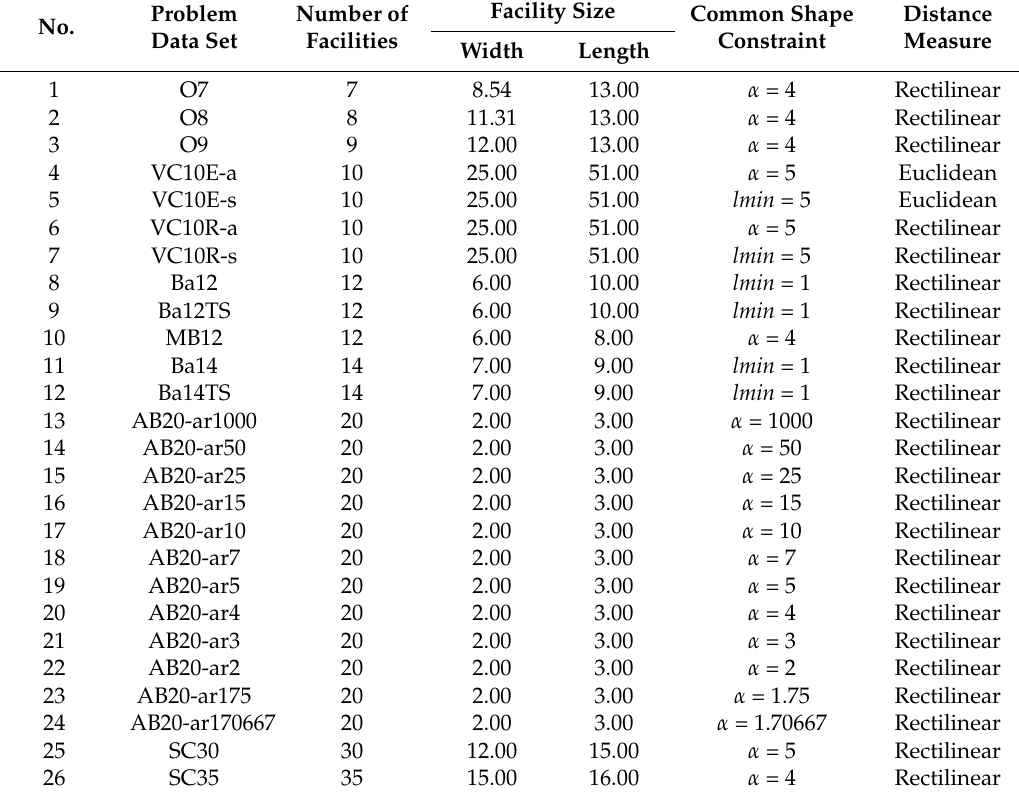
Table 2. The 26 well-known problem data sets.